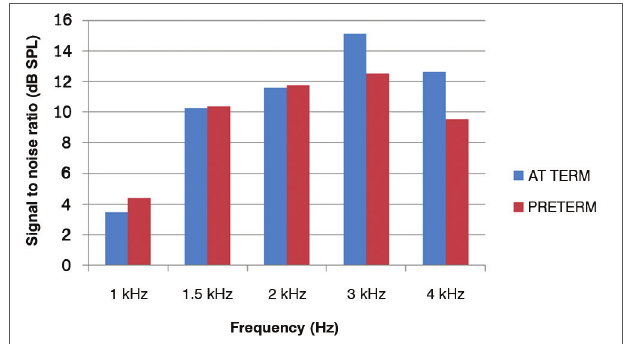
Figure 1. Mean levels of the signal-to-noise ratio (in dB SPL) in the sample studied, according to gestational